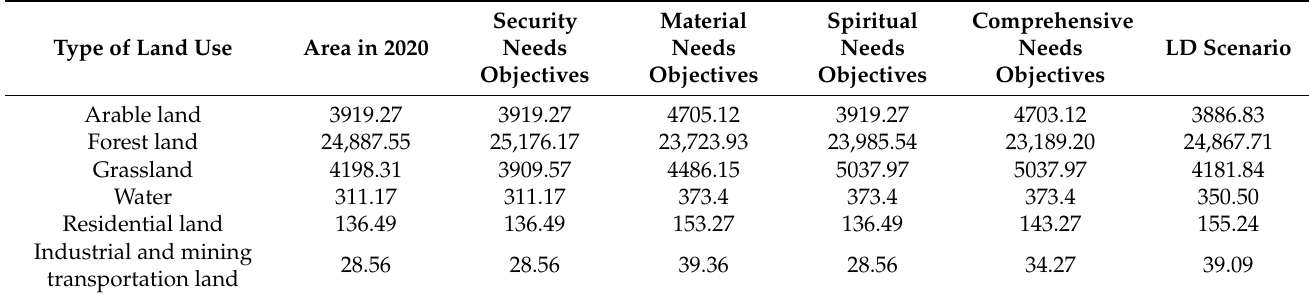
Table 5. Quantity optimization with multiple human needs goals (Unit (km 2